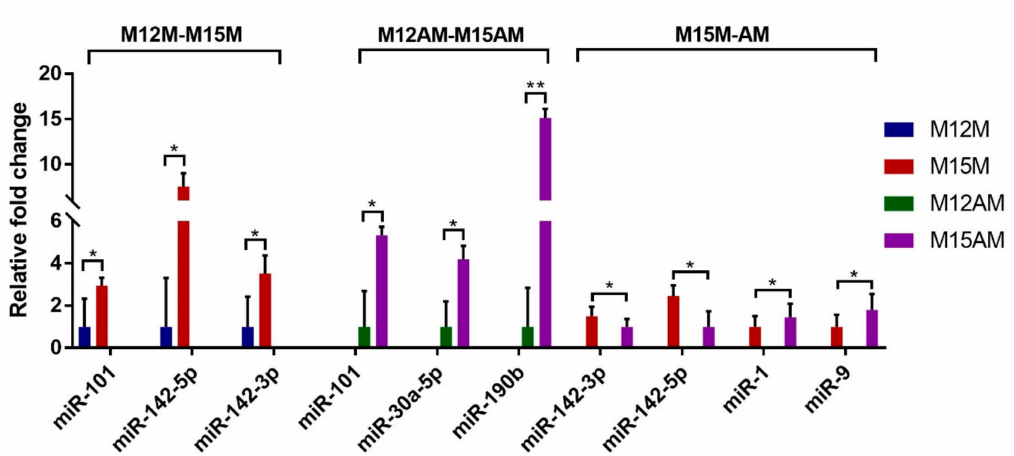
Figure 6. MiRNA expression profiling between the mesometrial side and anti-mesometrial sides of uterus at gestational days 12 and 15. ( a ) Expression profile of the di ff erentially expressed miRNAs at the mesometrial side of the uterus between gestational days 12 and 15; ( b ) Expression profile of the di ff erentially expressed miRNAs at the anti-mesometrial side of the uterus between gestational days 12 and 15. Each row represents an individual miRNA, and each column represents a sample. The color legend at the top indicates the level of miRNA expression. M12M, gestational day 12 at the mesometrial side of the uterus; M12AM, gestational day 12 at the anti-mesometrial side of the uterus; M15M, gestational day 15 at the mesometrial side of the uterus; M15AM, gestational day 15 at the anti-mesometrial side of the uterus.